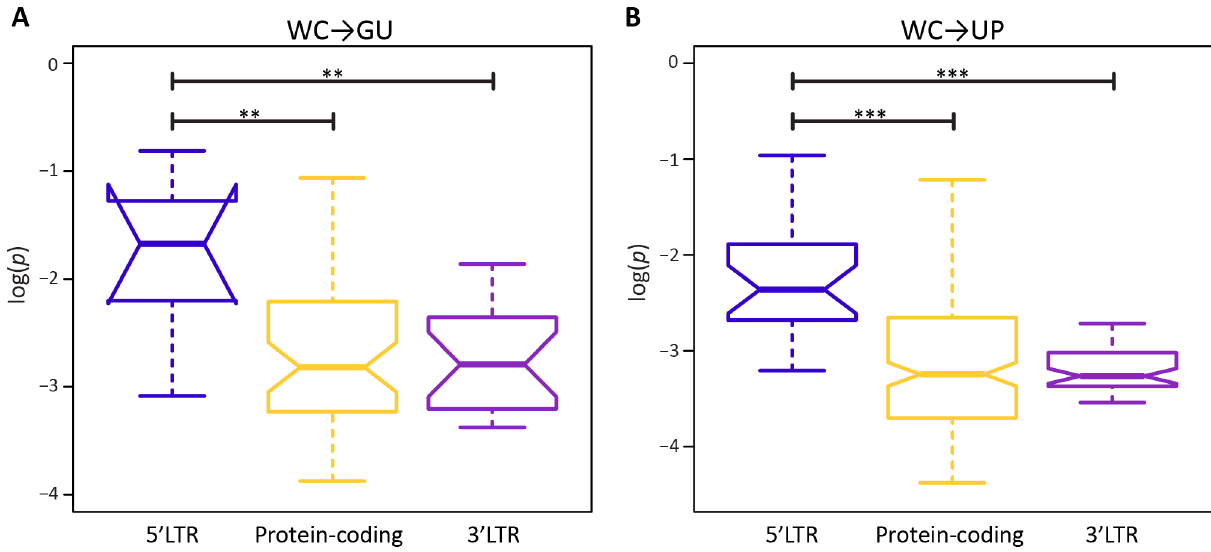
Figure 3. Intra-population frequencies of single-site WC replacement polymorphisms in 5 9 LTR, protein-coding, and 3 9 LTR regions of the HIV-1 genome. A ) Frequencies of WC R GU polymorphisms. B ) Frequencies of WC R UP polymorphisms. Frequencies are normalized to enable comparisons among classes (see Materials and Methods for details) and plotted on a log 10 -scale. Asterisks indicate p , 0.05 (*), p , 0.01 (**), and p , 0.001 (***).